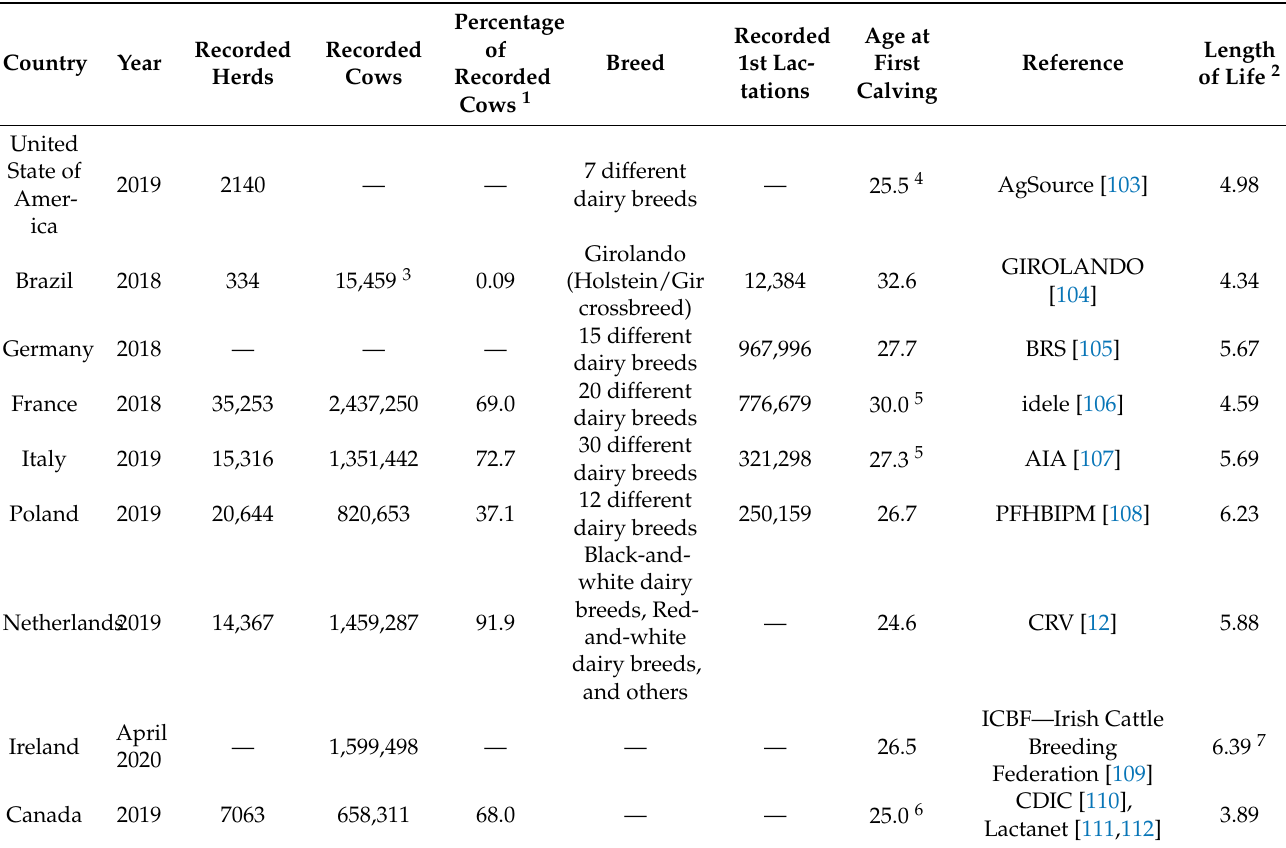
Table 4. Age at first calving (month) and length of life (year) of dairy cows in high milk-producing countries. The list of countries is limited to the world’s top high milk-producing countries for which we were able to provide sufficient and reliable data on the length of productive life and recent age at first calving from official milk recording